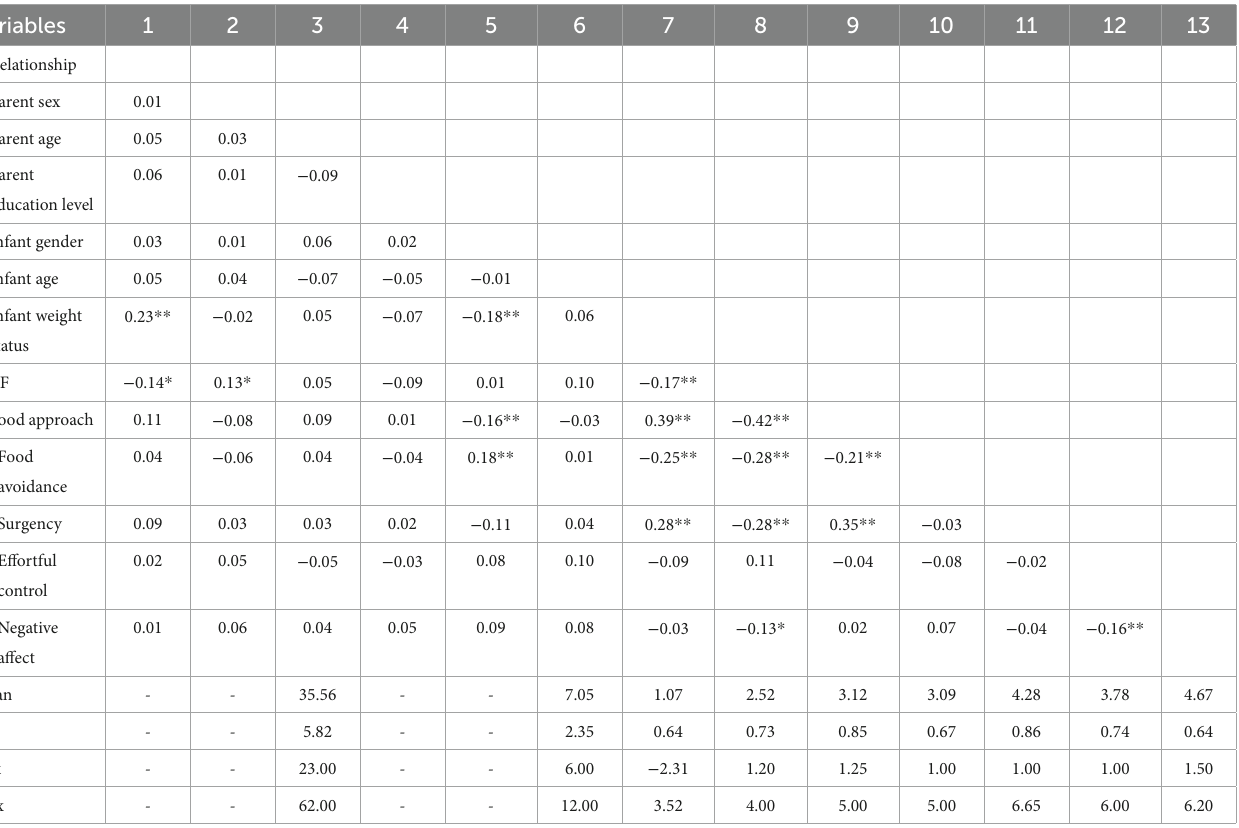
TABLE 2 Descriptive statistics and correlations for all the variables ( n = 616).